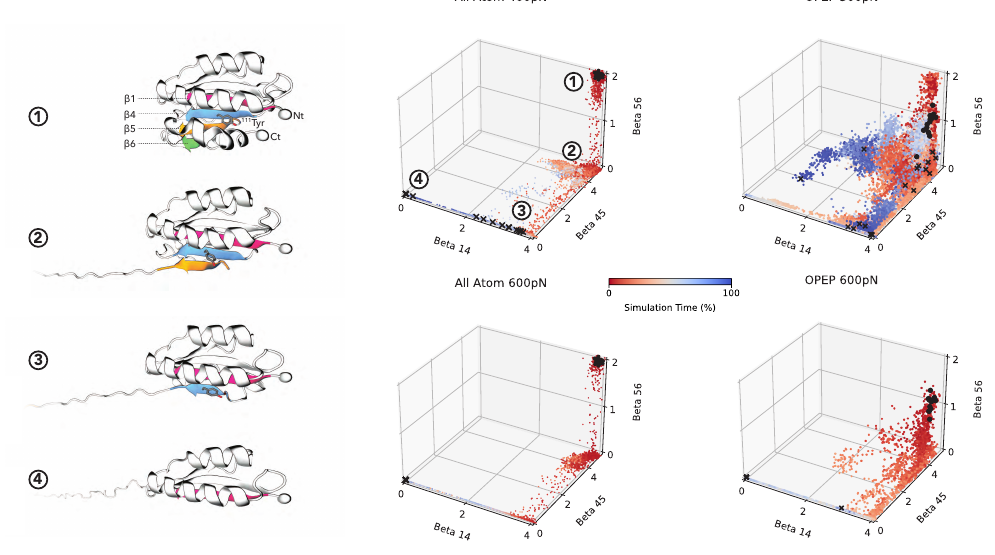
Figure 3. A2 unfolding path. ( Left ). From top to bottom, typical unfolding pathway of A2 in force-clamp simulation. As beta strands 6 (green), 5 (orange), 4 (blue) and 1 (red) unfold, residue 111 Tyr is more and more exposed. Snapshots were rendered in VMD and numbered 1–4. ( Center , Right ). The unfolding trajectories are projected on the 3-dimensional CV space of the native H-bonds between beta strands 1 and 4, 4 and 5, 5 and 6. Black dots and crosses denote the beginning and ending of the trajectories, respectively. Trajectories are colored from red (beginning) to blue (ending). In the first chart, the number 1 to 4 indicate the typical protein structure along the unfolding path shown in the left of the